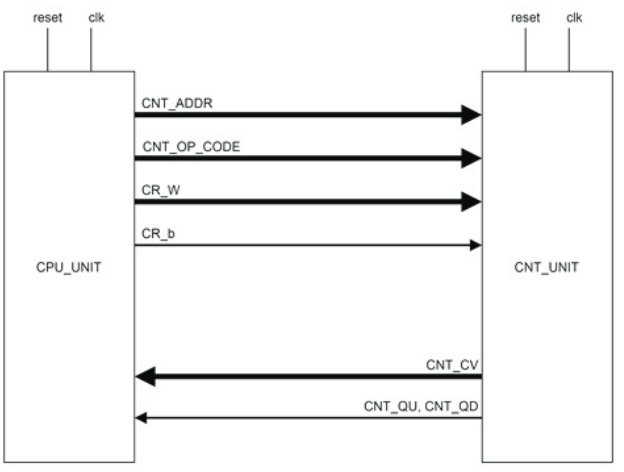
Figure 6. The interface between function unit and hardware-supported